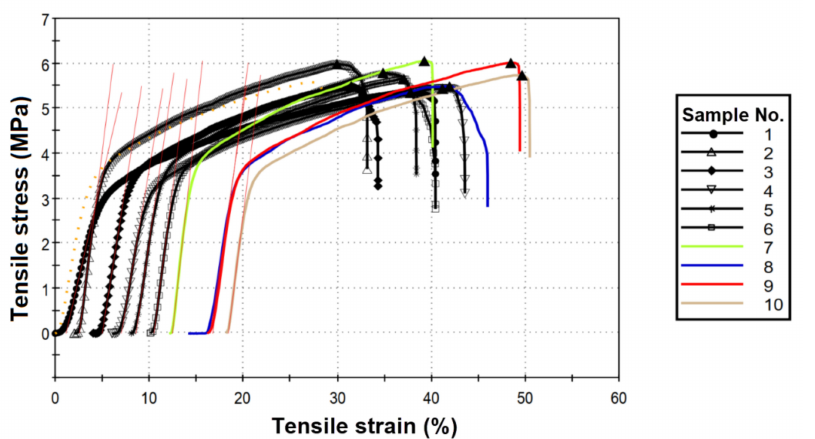
Figure 6. PVC nanofibers stress–strain diagrams, with rotation speeds of the collector at 1000 rpm. Table 2. Mechanical properties of PVC nanofiber mats with parallel orientated nanofiber. The Thickness of Tensile Strength, Young’s Modulus, Elongation at Break, Rotation Speed (rpm) σ ε Nanofiber Mats ( µ m) E (MPa) at break (%) at break (MPa) 0 73 ±